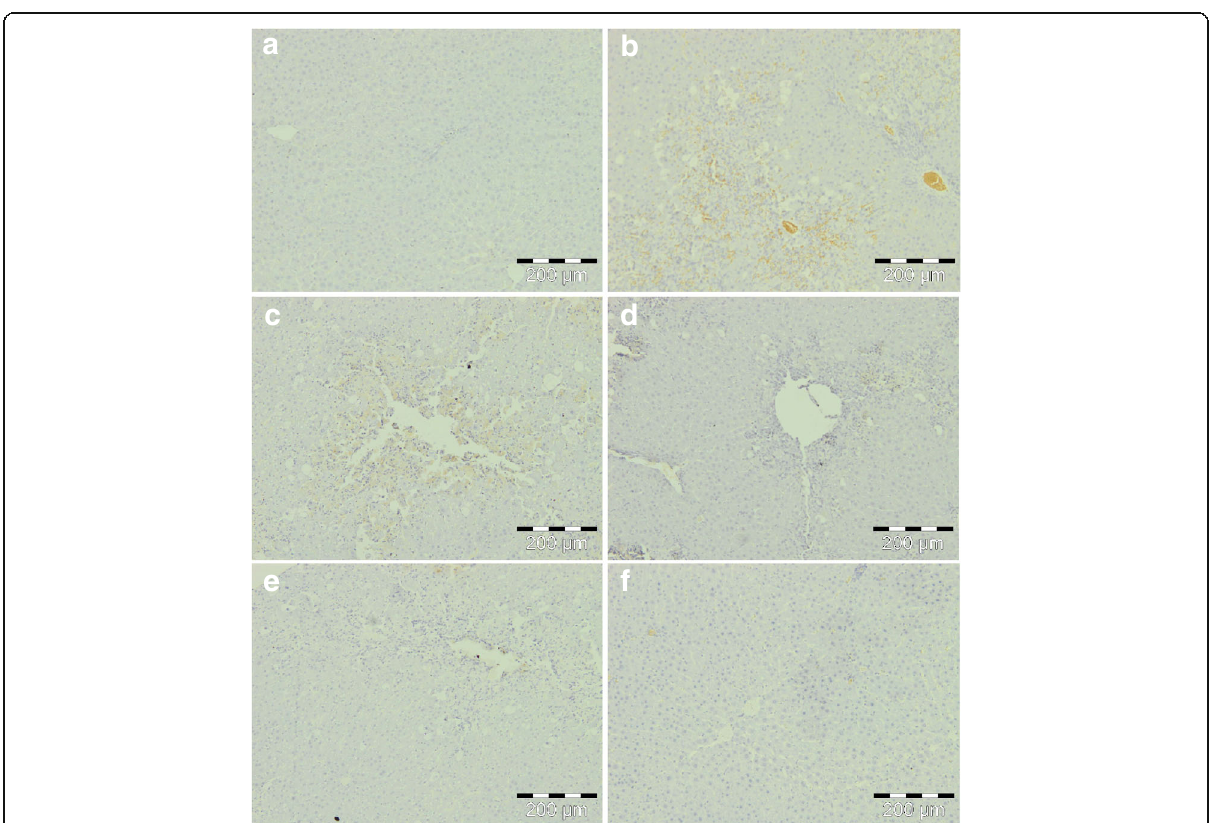
Fig. 8 Immunohistochemical appearance of HNE-modified protein adducts. a Control group, normal. b CCl4 (1 ml/kg b.wt.), increased formation of HNE-modified protein adducts. c C. nudiflora (150 mg/kg b.wt. + CCl 4 ), decreased formation of HNE-modified protein adducts. d C. nudiflora (300 mg/kg b.wt. + CCl 4 ), decreased formation of HNE-modified protein adducts. e C. nudiflora (450 mg/kg b.wt. + CCl 4 ), decreased formation of HNE-modified protein adducts. f C. nudiflora alone (450 mg/kg b.wt.),